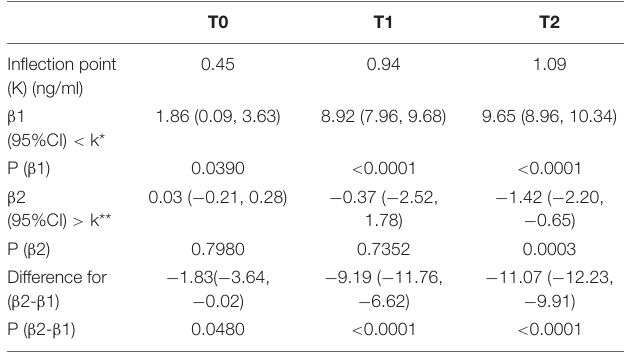
TABLE 3 | The analysis of the inflection points and the effect sizes of the curves reflecting the association of T levels and numbers of oocytes retrieved. T0 T1 T2